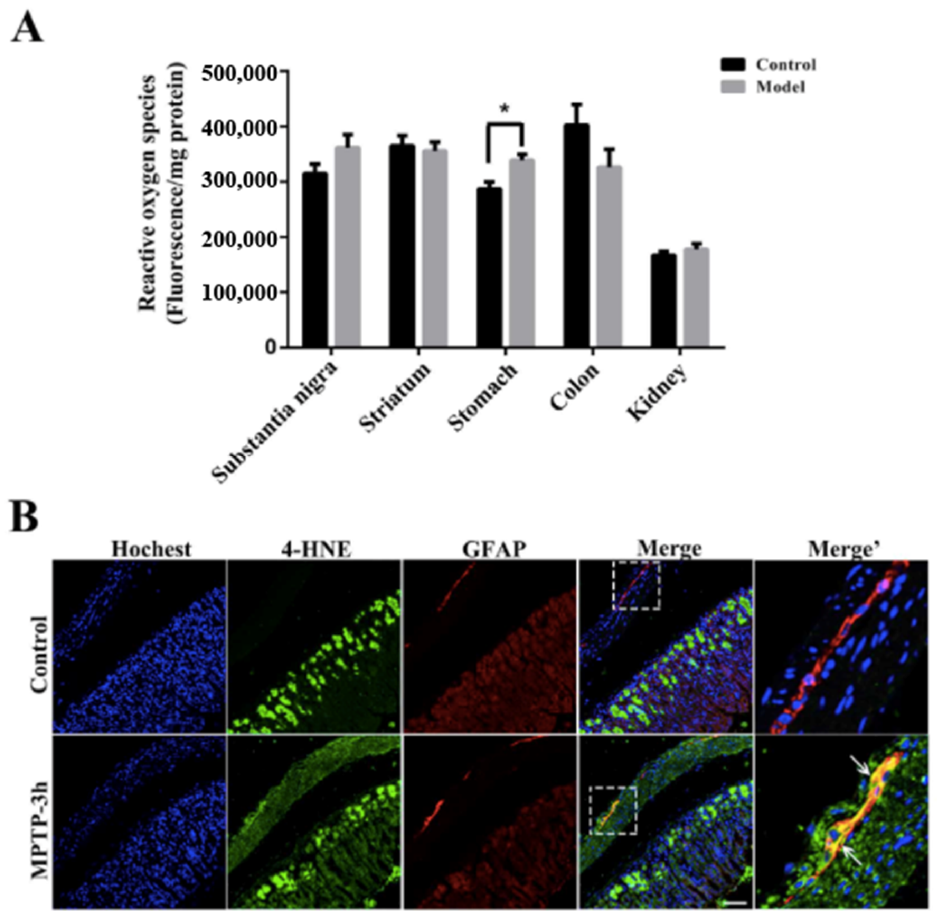
Figure 8. The stomach appears to undergo oxidative stress induced by MPTP before the SN, which is commonly thought to be easily affected; EGCs could be the first cell type affected by the MPTP-induced oxidative stress in the stomach. ( A ) A histogram representing ROS production across SN, STR, stomach, colon, and kidney 3 h after MPTP injection is shown ( n = 5, * p < 0.05). ( B ) 4-HNE (detected by anti-4-HNE antibody) localization in stomach sections from control and model mice, additionally stained for GFAP (scale bar = 50 µ m). White arrows refer to 4-HNE and GFAP co-expression in the